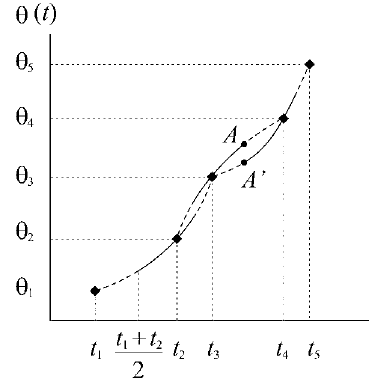
Fig. 9. Most unfavorable case for varying shaft acceleration. Key: (cid:2) = pulse arrival time.